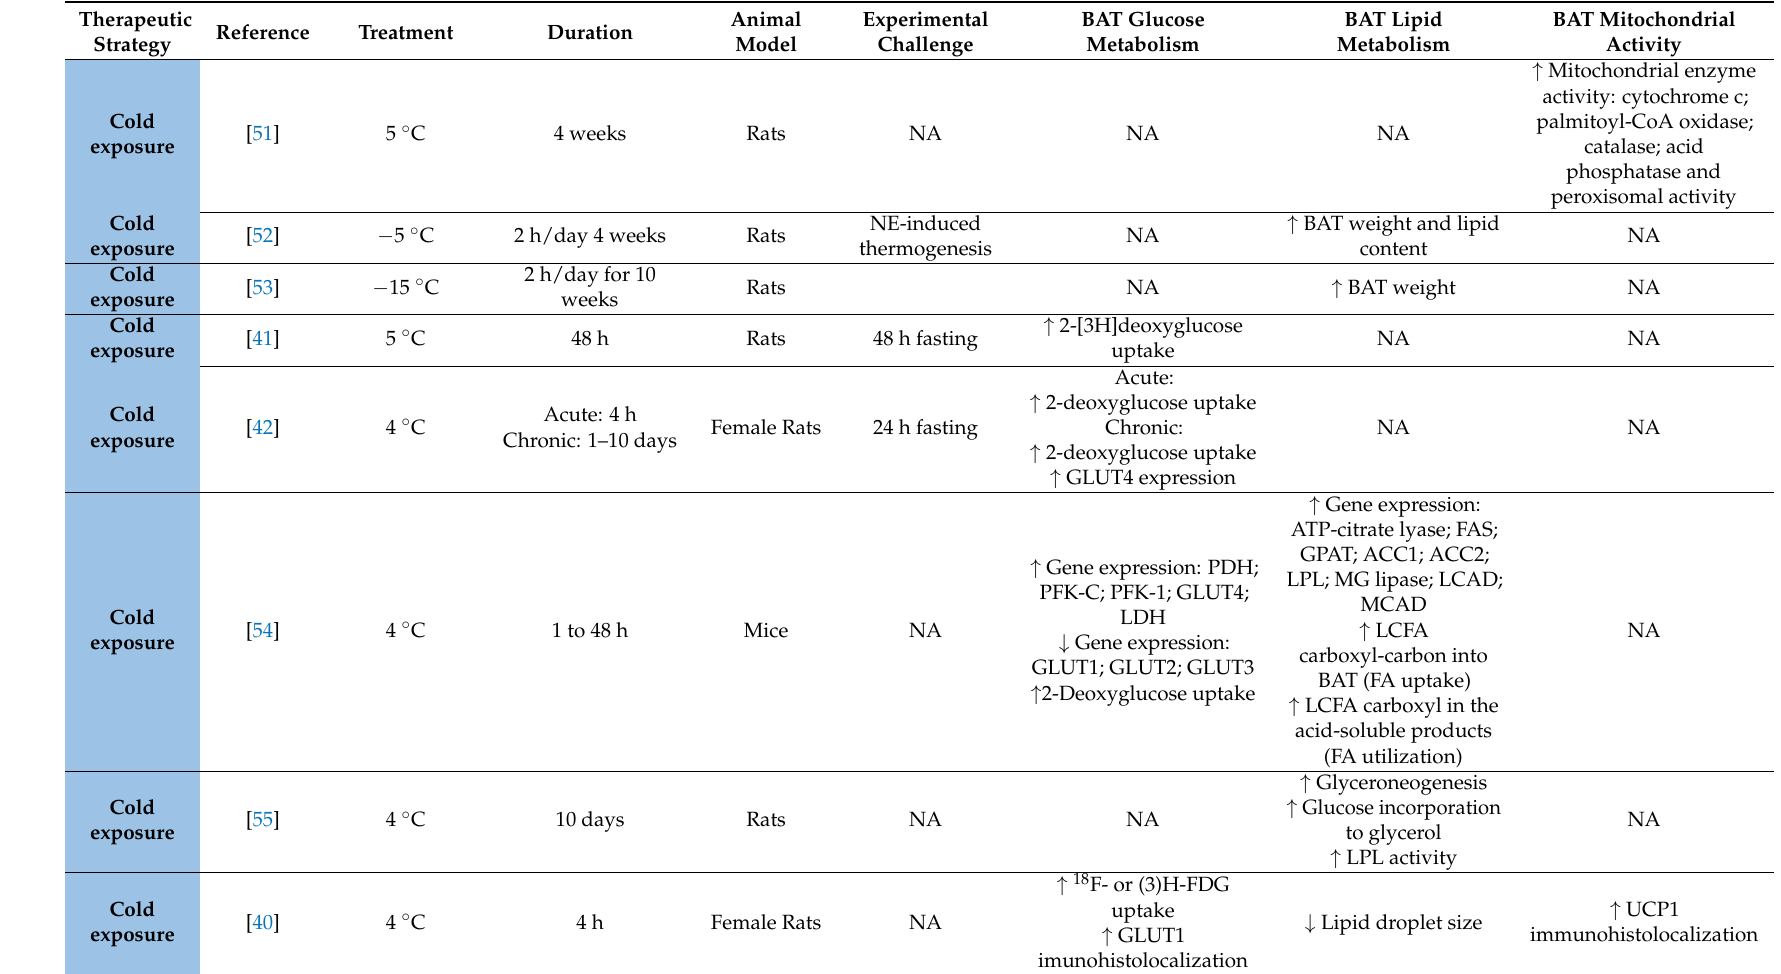
Table 1. Effect of cold and exercise on BAT metabolism in